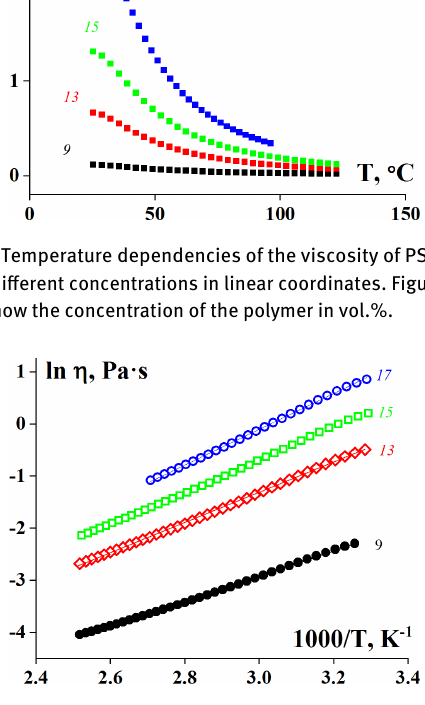
Figure 5: Temperature dependencies of the viscosity of PSu solu- tions of different concentrations in Arrhenius coordinates. Figures at the curves show the concentration of the polymer in vol.%.